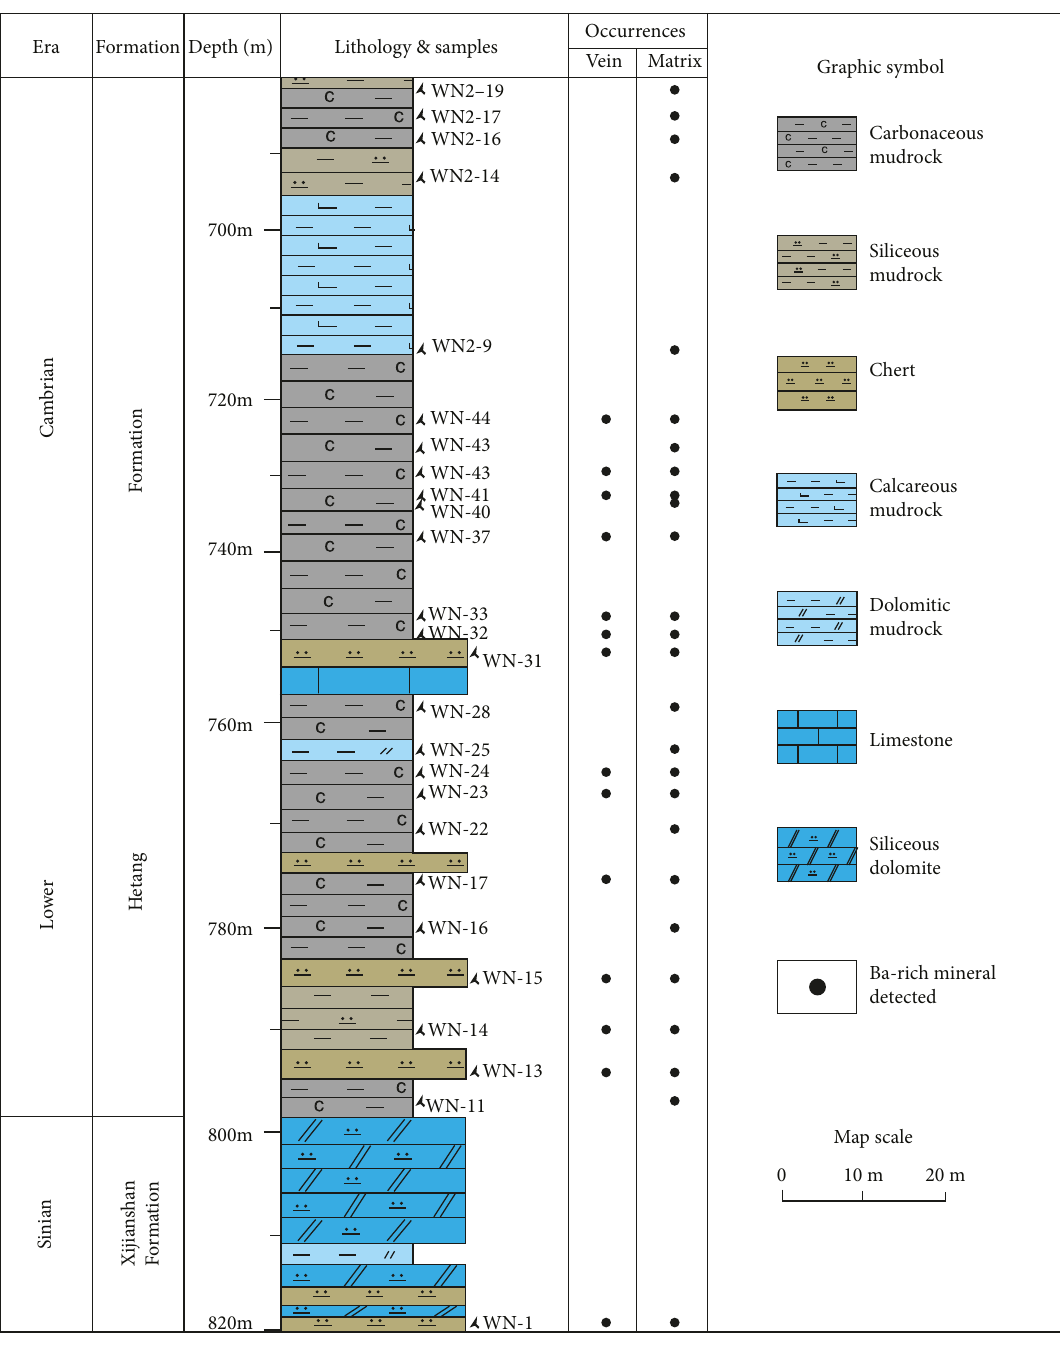
Figure 2: Petrological pro fi le of Well Wanning 2. The depth of each sample analyzed by EMPA is labelled, along with the occurrence of Ba- rich